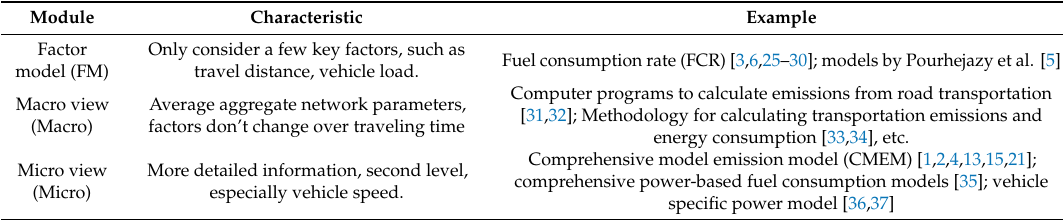
Table 1. Classification of models estimating